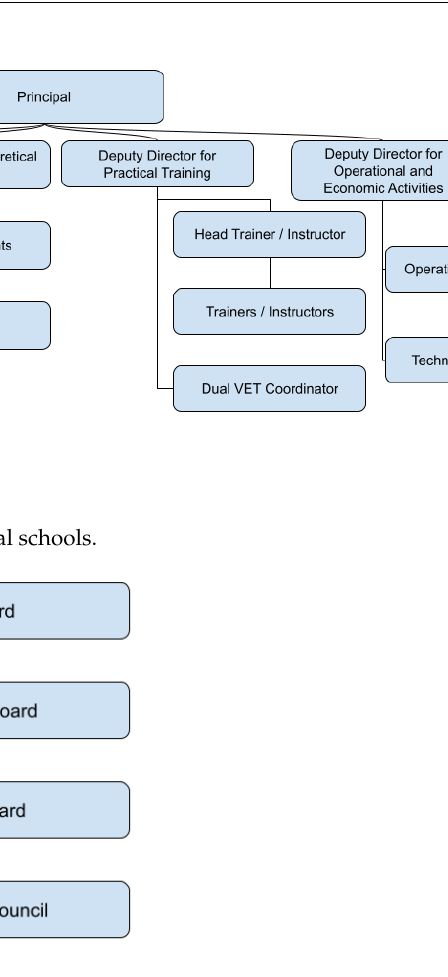
Figure 2. Principal’s advisory bodies.